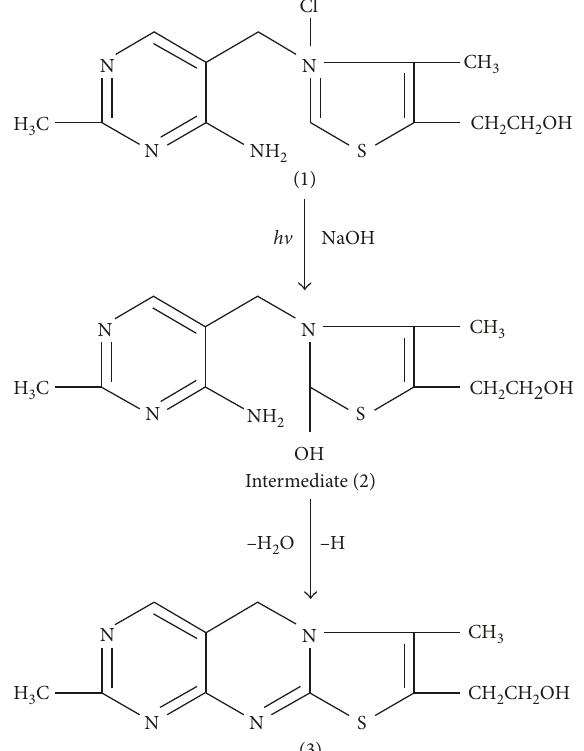
Figure 1: Photochemical dehydrogenation of thiamine (1) to thiochrome